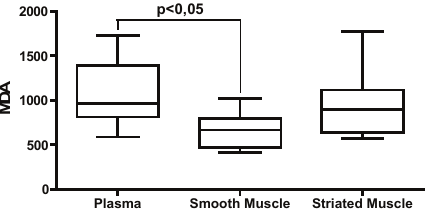
FIGURE 4 - Intragroup comparison of the levels of MDA (ng/mL) in the various analysed tissues for the control group (ANOVA; p=0.0201).